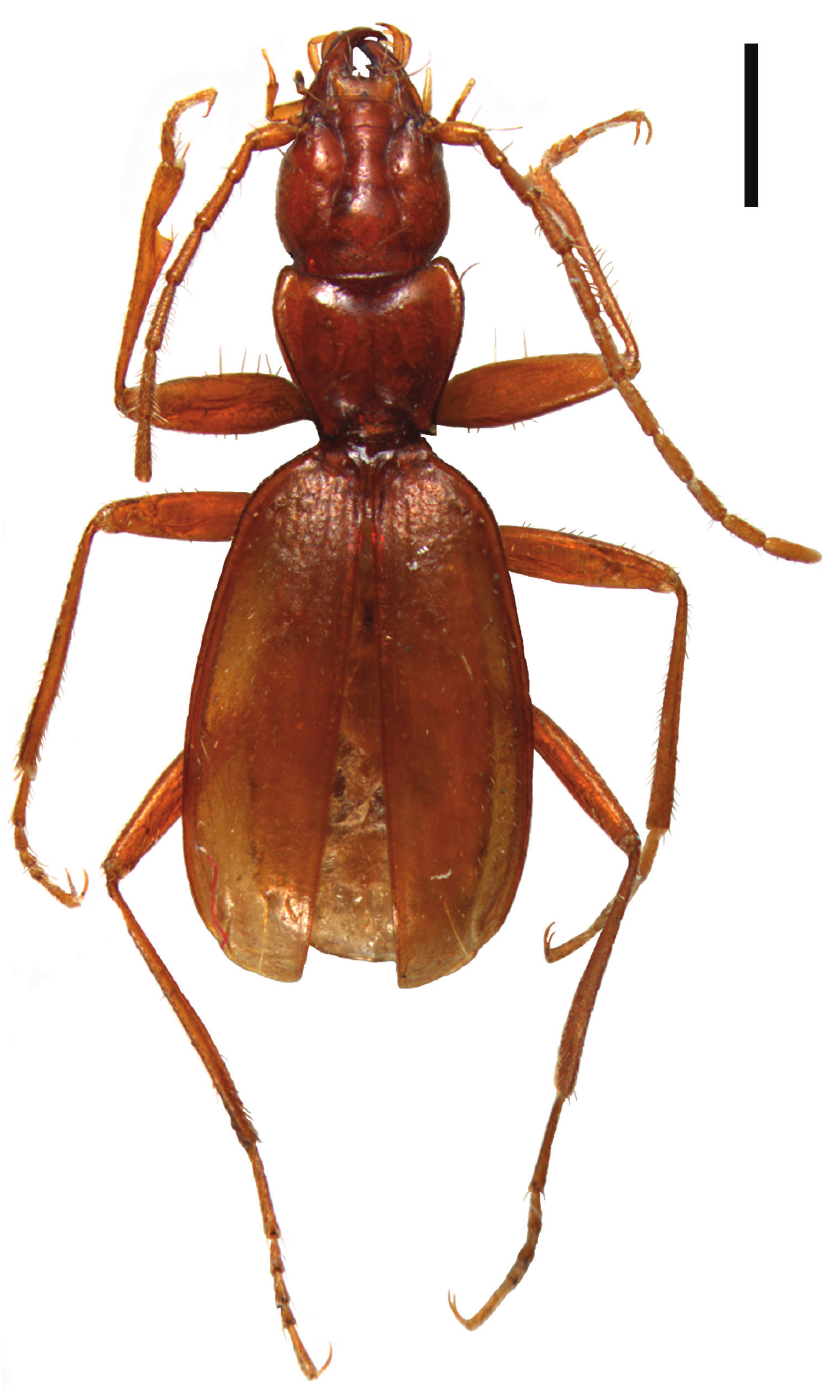
Figure 1. Beronaphaenops gen. n. paphlagonicus sp. n. Photo of habitus, holotype. Scale bar: 1